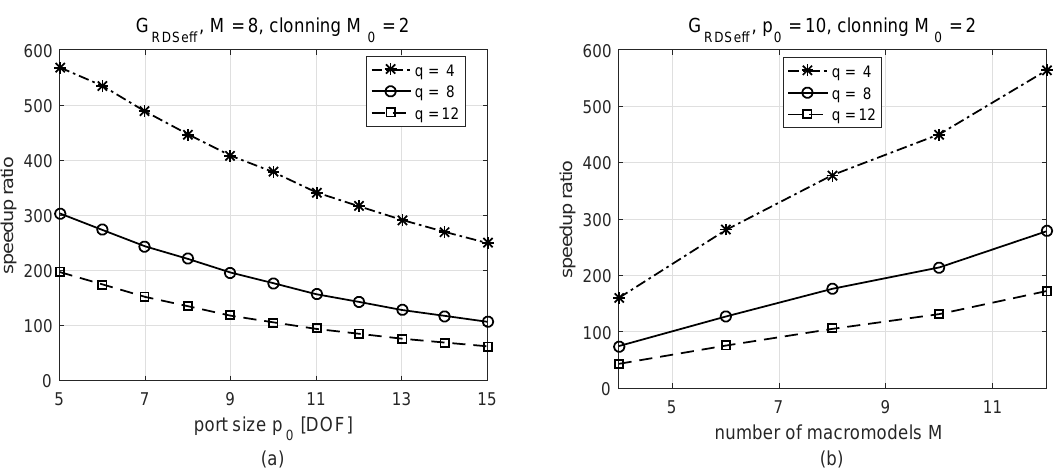
Figure 9. Effective gain of MOR with diagonalization G RDSeff , with cloning: versus port size p 0 for M = 8 ( a ); and versus number of macromodels M for p 0 = 10 ( b ).